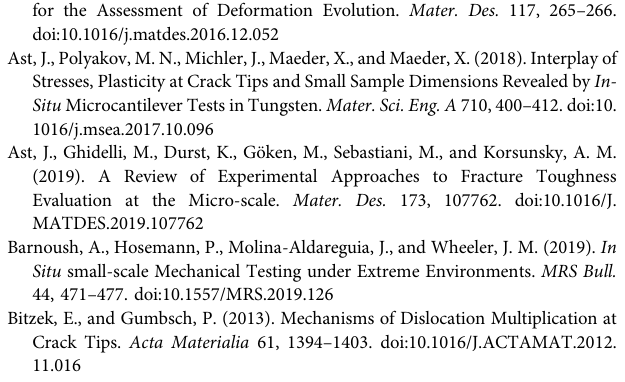
Figure 6C . Moreover, the post-mortem fractograms in Figure 2 indicate the beginning of the quasistatic separation at the crack tip notch, which has been observed in electrolytic hydrogen- treated steels in WWER-440 reactor as “ ductile separation mechanism ” (dimple-shaped surface) (Yasniy et al., 2013). In summary, the microstructure-property relationship suggests that HeIC can be alleviated through the laser welding process, which creates an annealed HAZ microstructure that behaves in a more ductile manner than the irradiated base